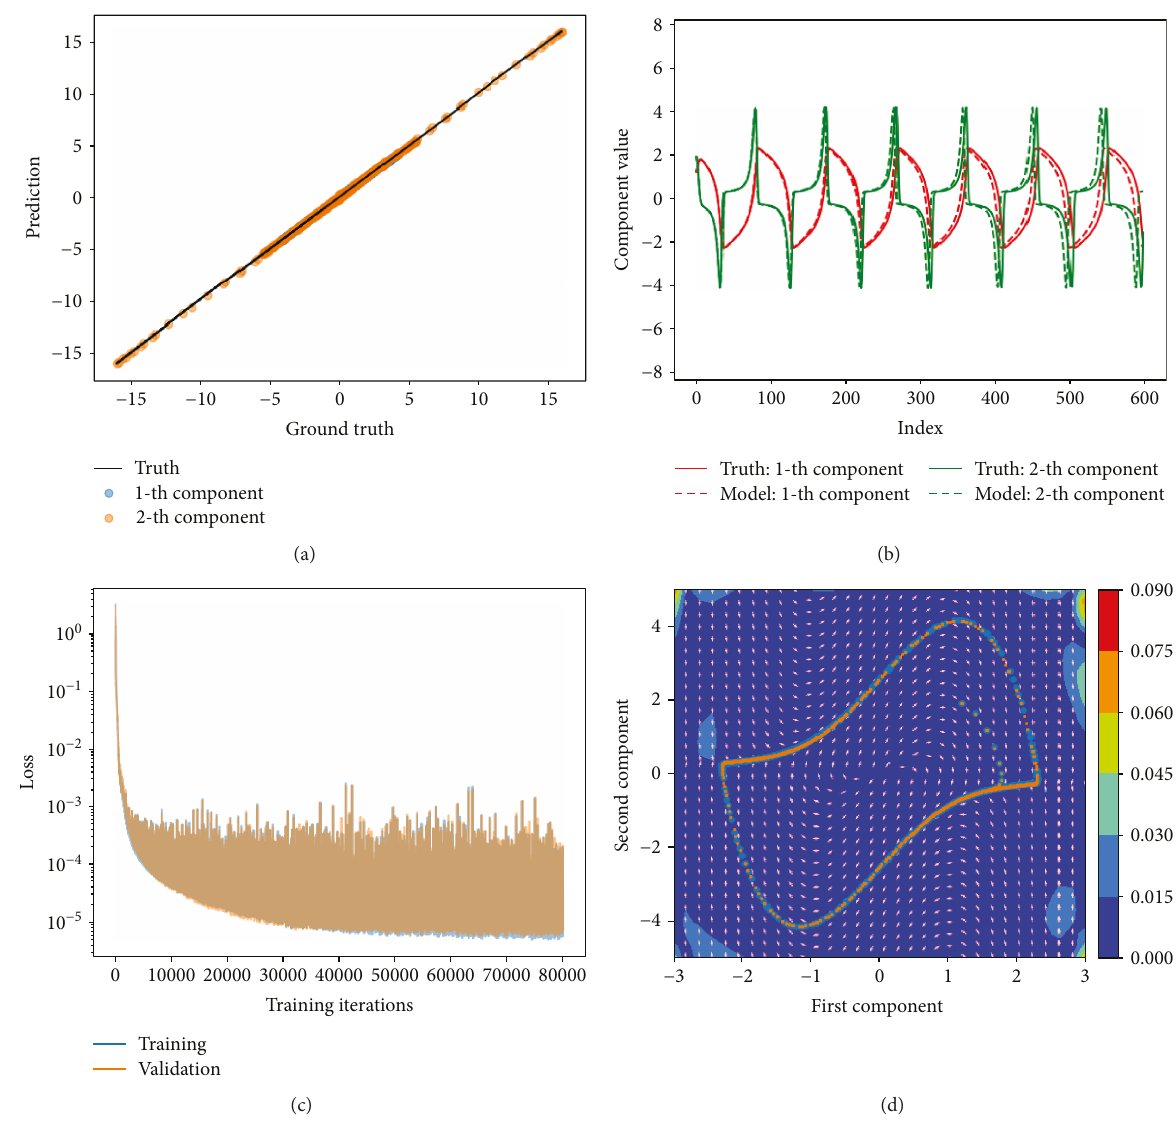
Figure 21: A priori and a posteriori result of the basic model on the VDP system, training with random sampled data distribution. (a) A priori evaluation. (b) A posteriori evaluation. (c) Learning curve. (d) Stepwise error contour. Blue dot: ground truth. Orange dot: prediction. White arrow: direction of target vector of ground truth. Red arrow: direction of target vector of